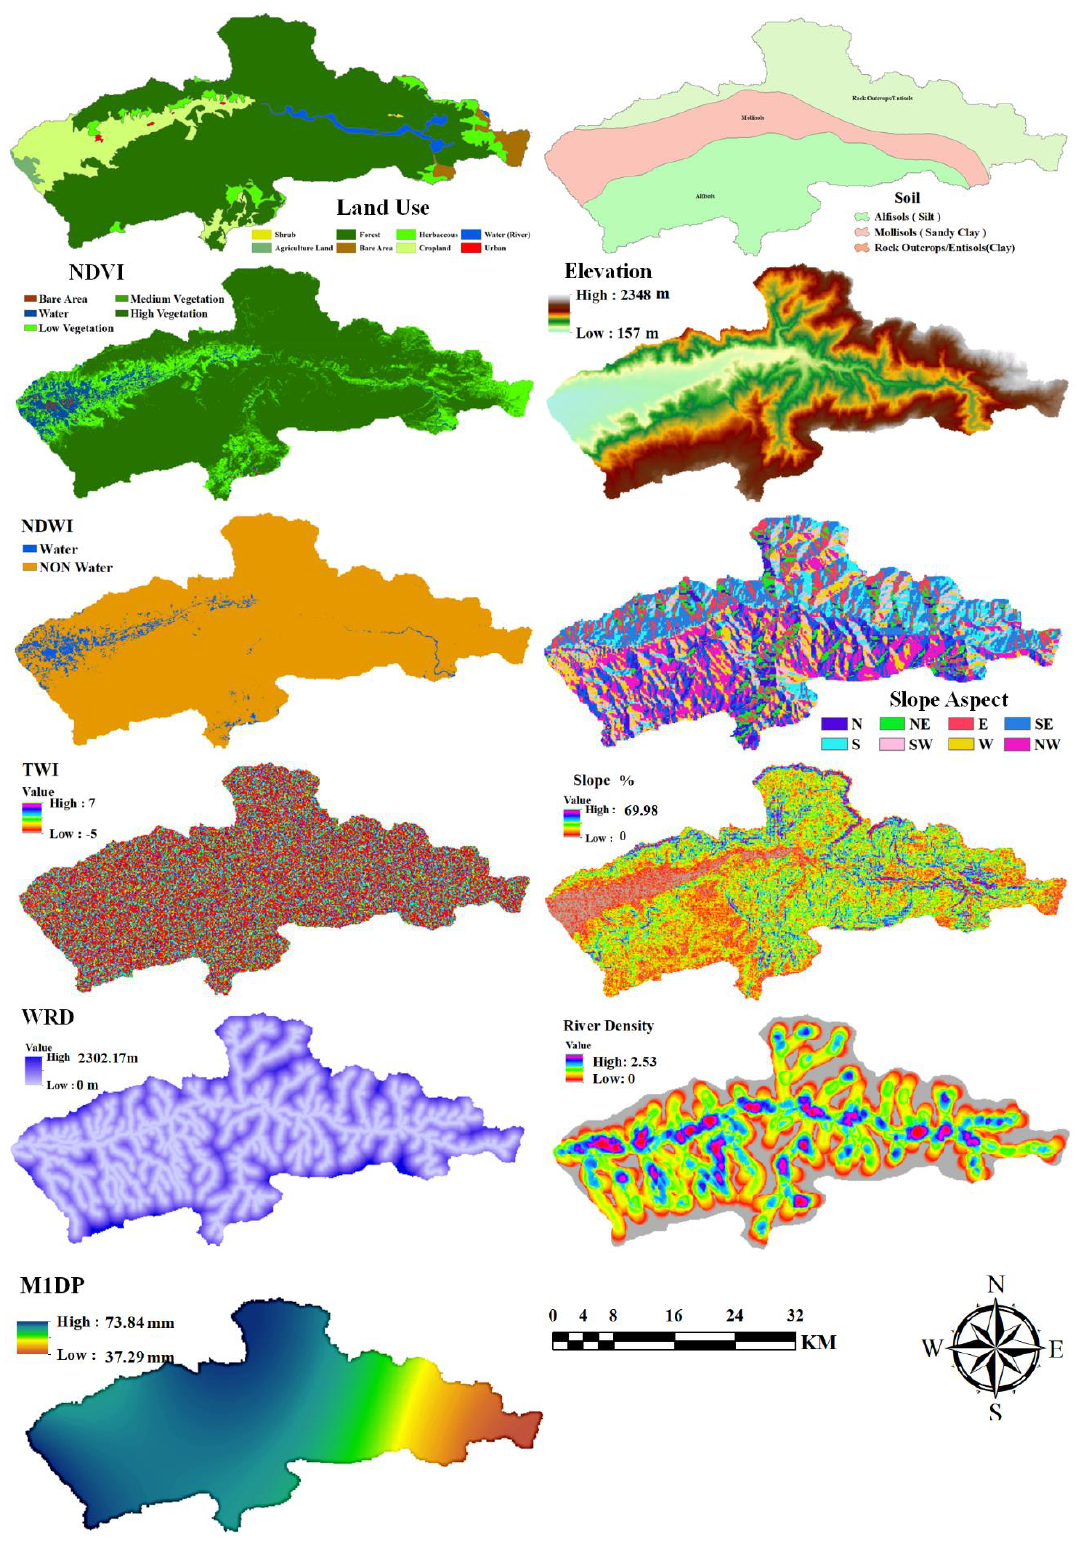
Figure 5. Characteristic distributions of risk indices.